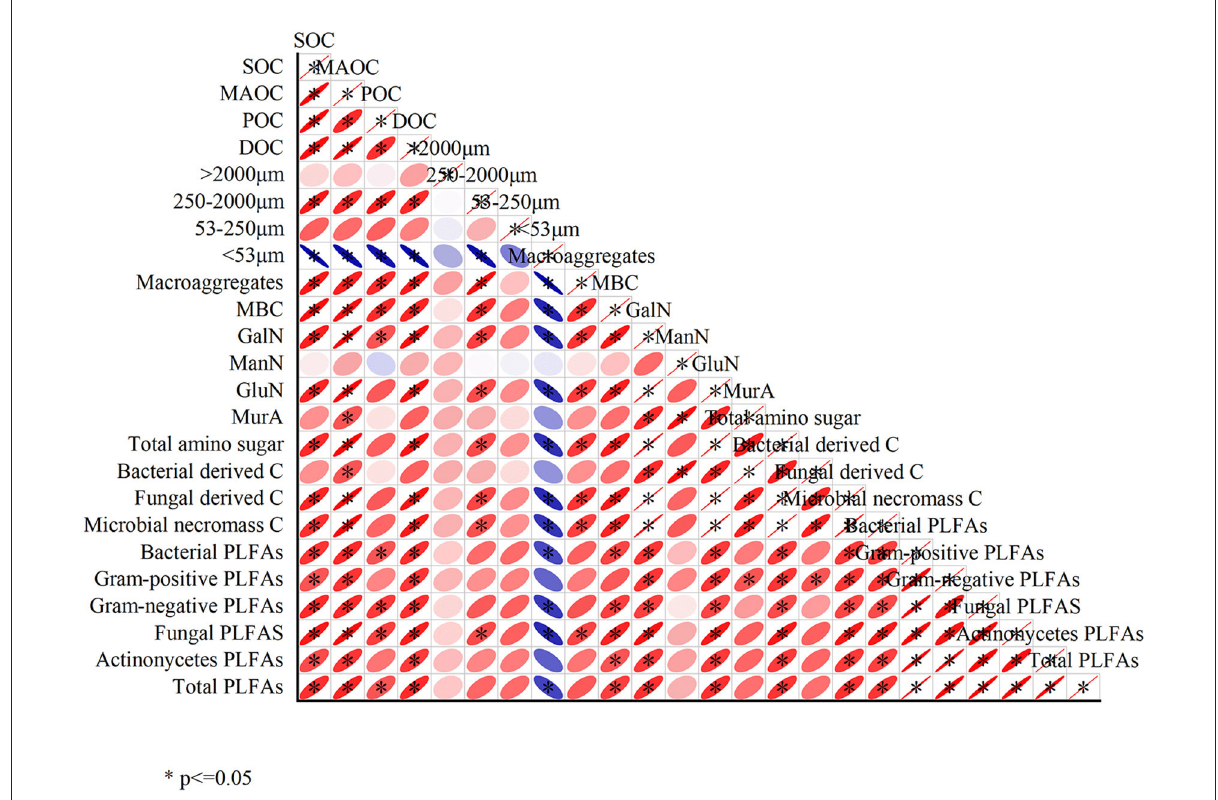
FIGURE5 Relationships among different variables. *indicate significance at p < 0.05.